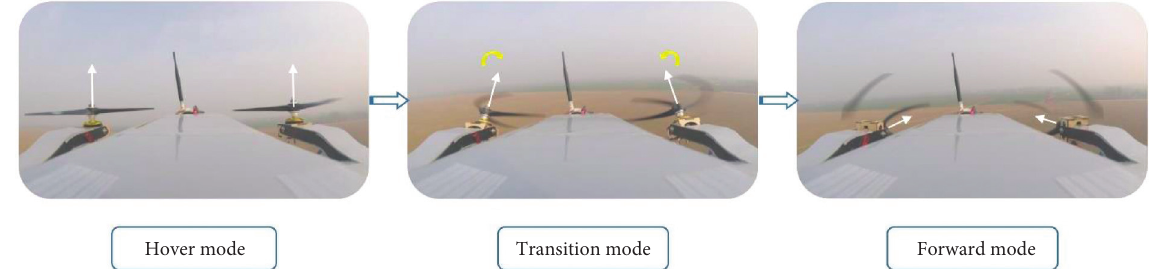
Figure 18: Mode transition in the flight